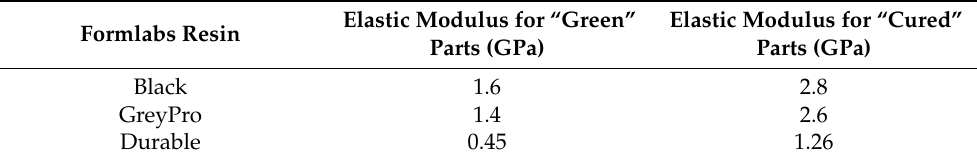
Table 2. Elastic modulus for parts printed with Formlabs resin [23]. “Green” parts refer to parts that have not been through any post-processing treatment. “Cured” parts refer to parts that have been through the suggested best post-process treatment (UV-light and heat).